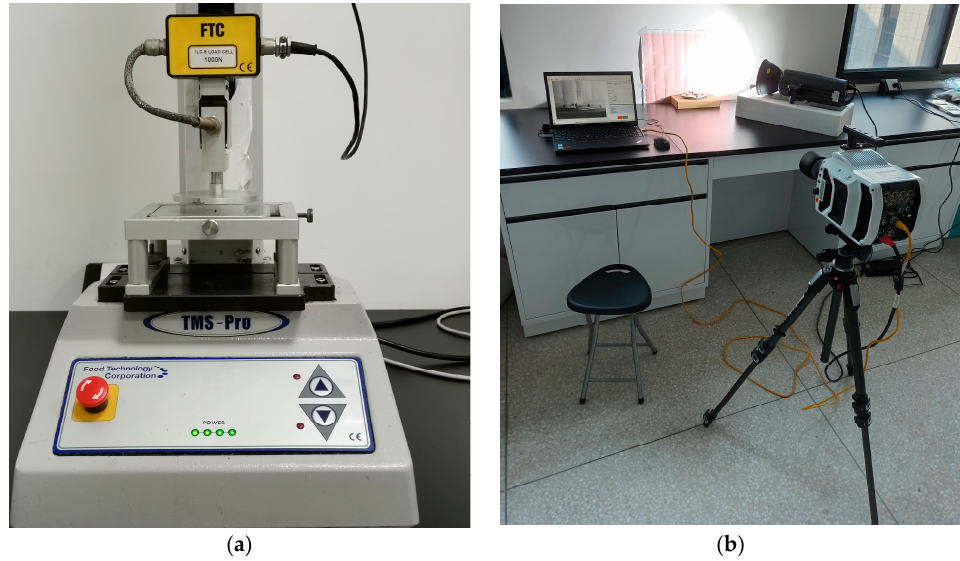
Figure 8. ( a ) Calibration process of Poisson’s ratio and shear modulus; ( b ) calibration process of coefficient of restitution.